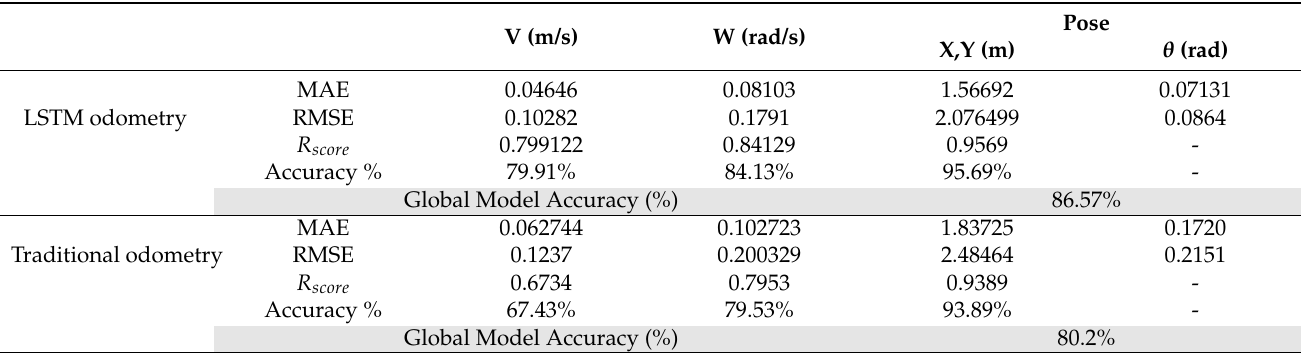
Table 1. Error values obtained by comparing the LSTM odometry model and the traditional odometry with respect to the velodyne data.